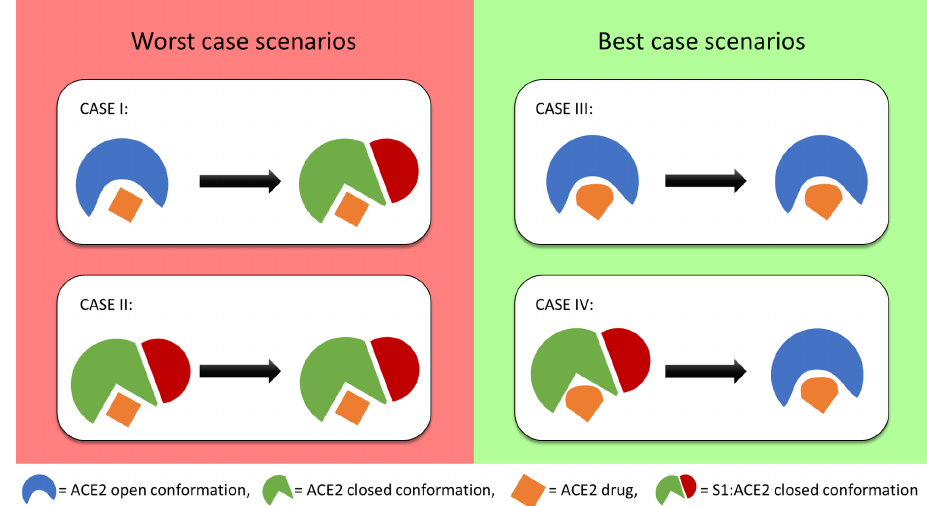
Figure 5. Proposed mechanism of drug action for allosteric inhibitors of ACE2:S1 binding. Case I and Case II represent undesired stabilization of the ACE2:S1 complex. Case III and Case IV represent ACE2:S1 complex inhibitors due to allosteric disruption of the ACE2 binding interface, resulting in the stabilization of the open ACE2